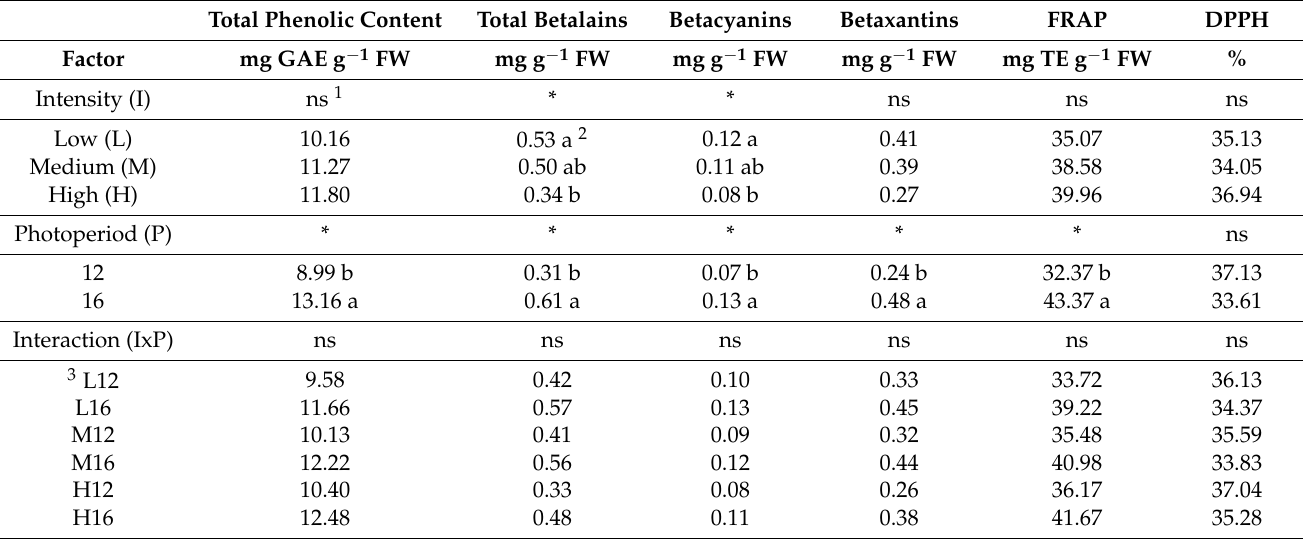
Table 3. Total phenolic content, total betalain content (betacyanins + betaxanthins), and antioxidant capacity (FRAP and DPPH) of beet microgreens under different light treatments. Values are the mean of 3